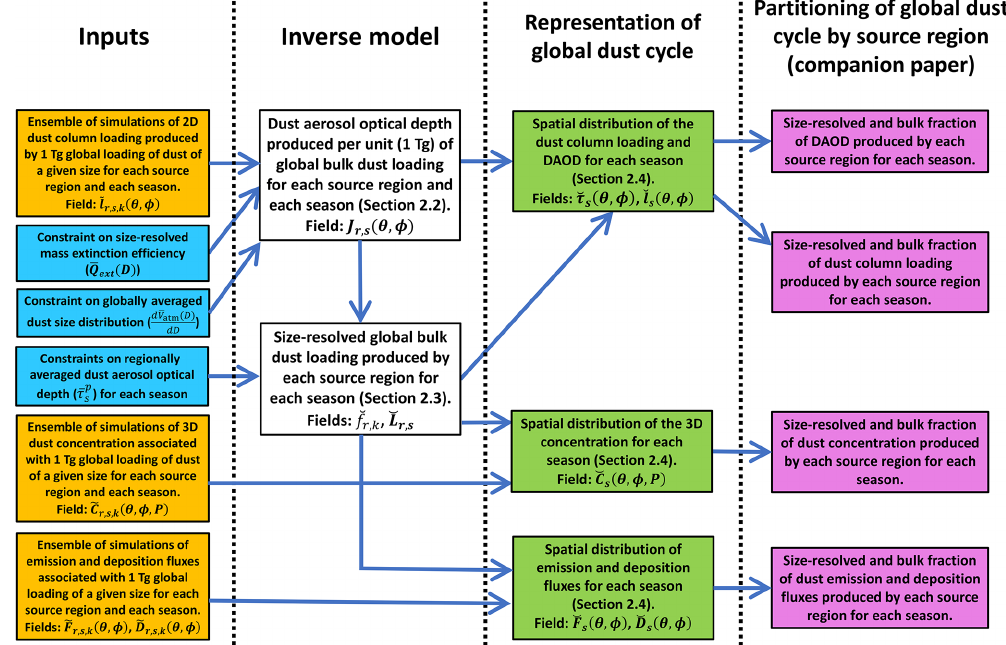
Figure 1. Schematic of the methodology used to obtain an improved representation of the global dust cycle. Yellow boxes denote inputs from an ensemble of global model simulations, blue boxes denote inputs from observational constraints on dust properties and abundance, and white boxes denote the inverse model. We report the resulting representation of the global dust cycle in the present paper (green boxes) and the partitioning of the global dust cycle by source region (magenta boxes) in our companion paper (Kok et al., 2021a). The subscripts r , s , and k respectively refer to the originating source region, the season, and a model’s particle size bin. Other variables are defined in the main text and the